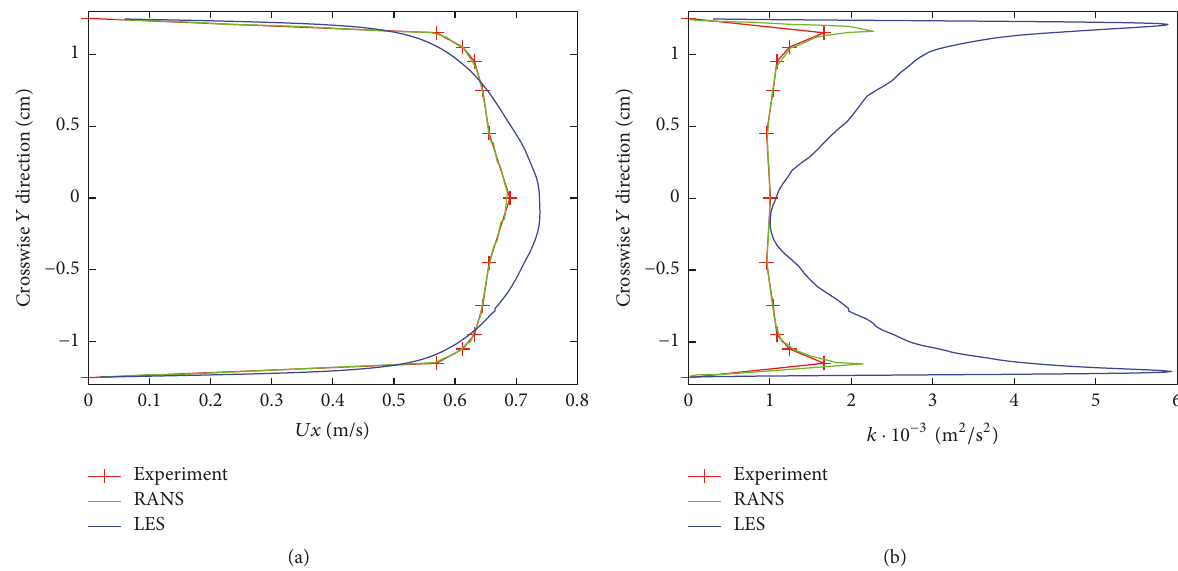
Figure 7: Streamwise velocity profile (a) and turbulence kinetic energy (b) profiles on the